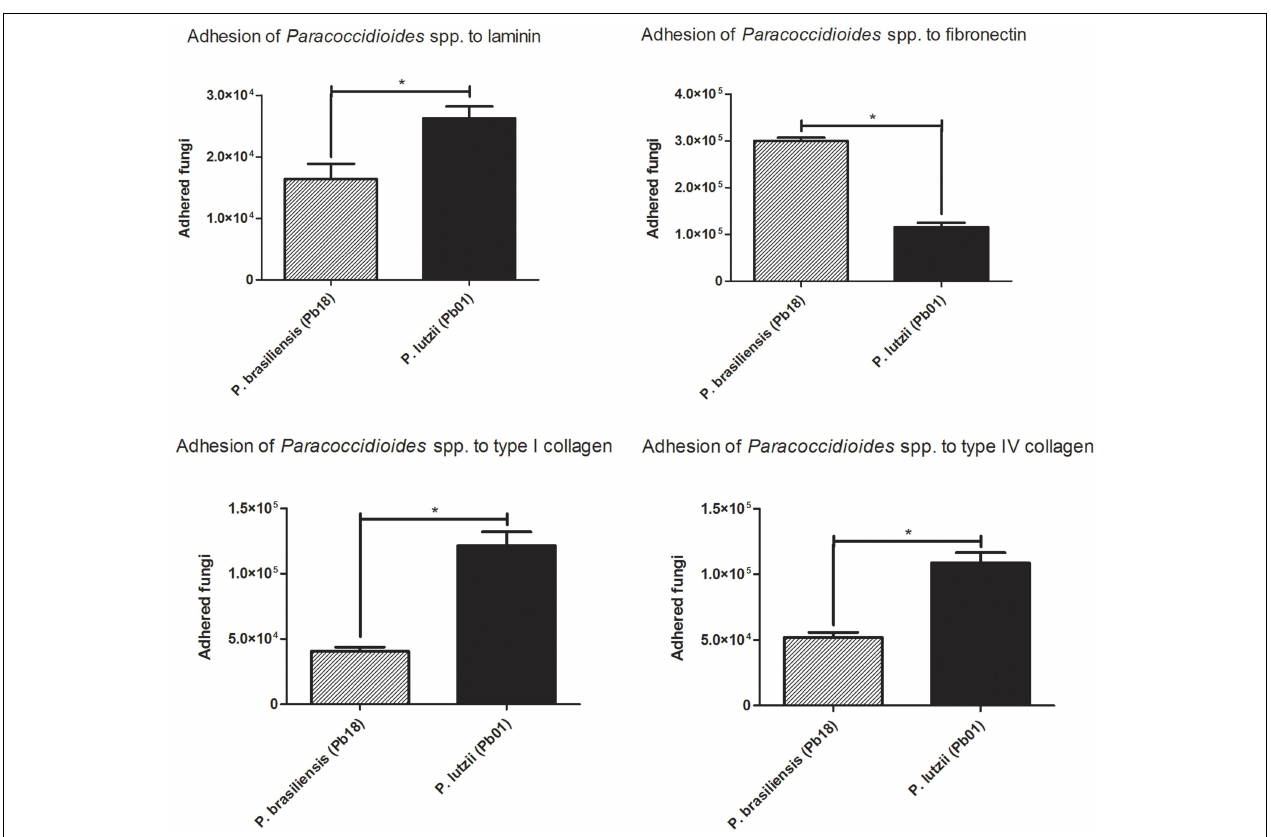
FIGURE 2 | Adhesion profile to ECM components. Adhesion profiles of the different species of the genus Paracoccidioides to the ECM components (laminin, fibronectin, Type I collagen and Type IV collagen) after 2h of infection. * Indicates a statistically significant difference in the adherence rate, p < 0 . 05